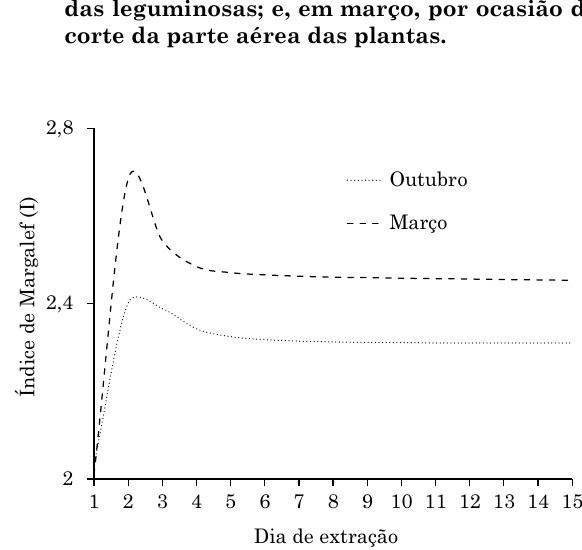
Figura 6. Variação diária do índice de Shannon (H’), por causa da quantidade de organismos capturados, discriminada por tratamentos [feijão-de-porco ( Canavalia ensiformis ), mucuna-preta ( Mucuna aterrima ), feijão-bravo-do-Ceará ( Canavalia brasiliensis ), guandu ( Cajanus cajan ) e vegetação espontânea], referente à segunda